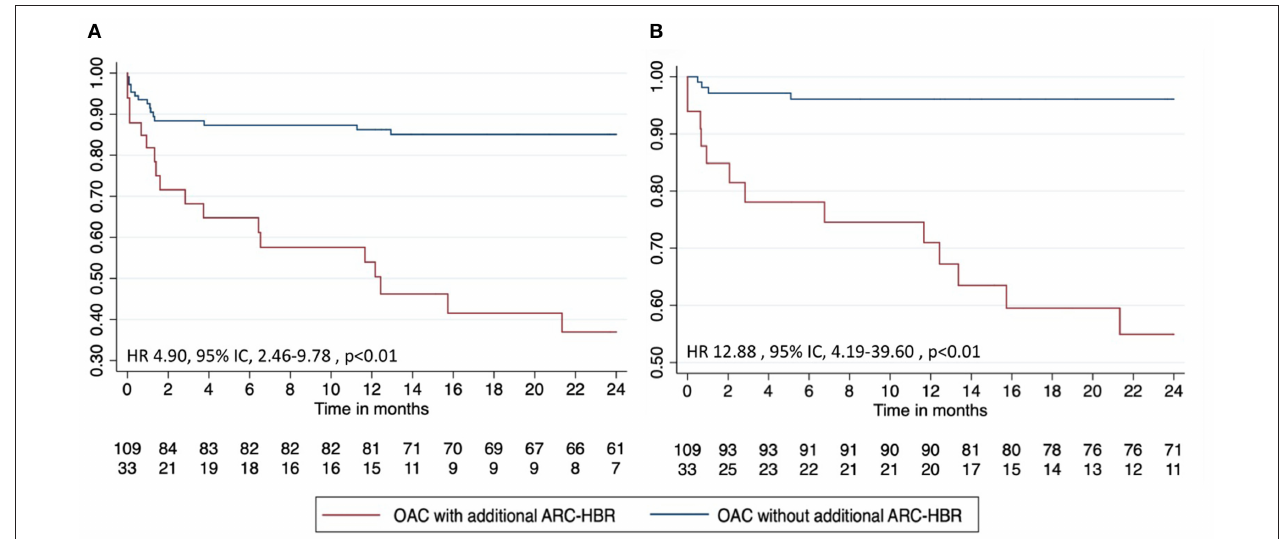
FIGURE 2 | Bleeding-free survival according to major criteria for (A) any bleeding and (B) major bleeding. ARC, Academic Research Consortium High Bleeding Risk; HBR, high bleeding risk; OAC, oral anticoagulation; TAT, triple antithrombotic therapy.